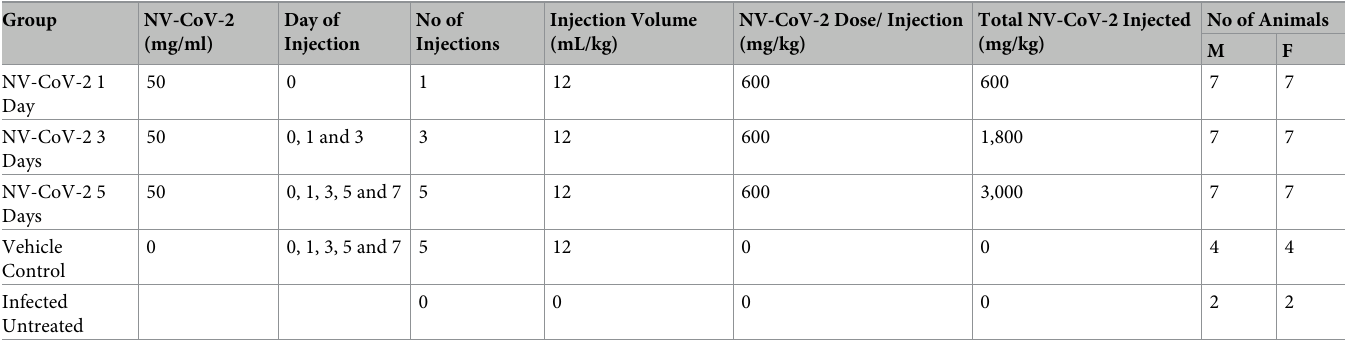
Table 2. The groups of animals and the treatment